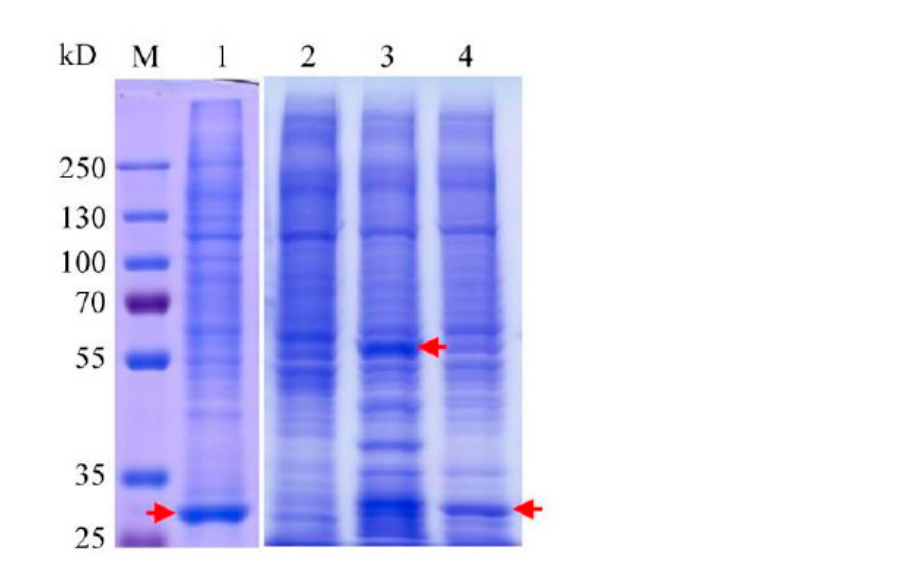
Figure 4. SDS-PAGE analysis of pull down assays using His 6 -PACRG and His 6 -GST-PACRG as baits. Lane 1: pull down assay using His 6 -GST as bait. Arrow indicates the position of His 6 -GST. Lane 2: pull down assay of Ni 2+ -charged resin. Lane 3: pull down assay using His 6 -GST-PACRG as bait. Arrow indicates the position of His 6 -GST-PACRG. Lane 4: pull down assay using His 6 -PACRG as bait. Arrow indicates the position of His 6 -PACRG. Table 1. Function classifications of the Parkin co-regulated gene (PACRG) interaction partners. S.